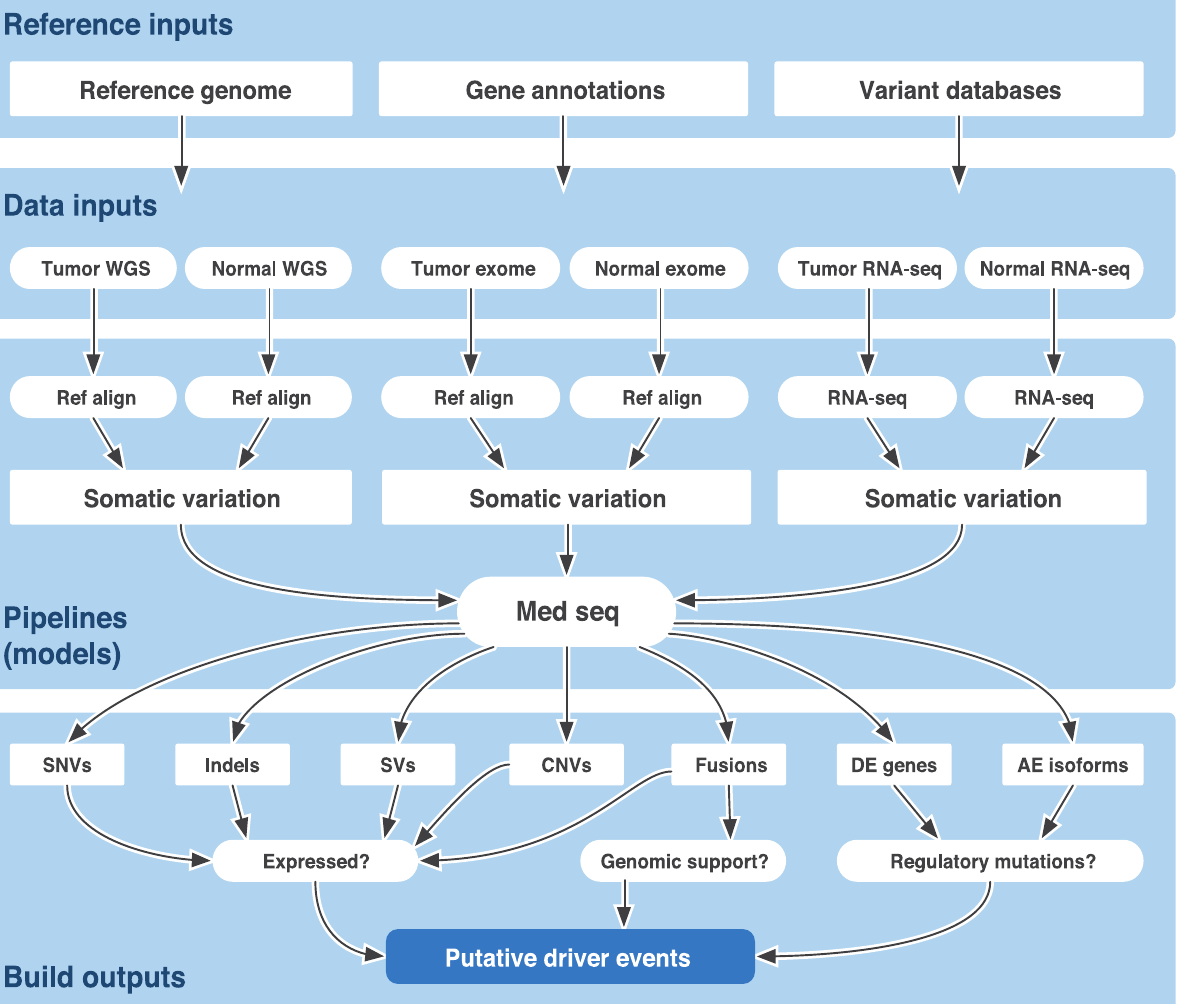
Fig 4. HCC1395 ( “ TST1 ” ) example input, models, and outputs. A test dataset for the HCC1395 cell line is provided with the GMS software to allow testing of software installation, and facilitate further development. It is also used to illustrate much of the current functionality of the GMS. HCC1395 tumor and the corresponding HCC1395BL ‘ normal ’ cell line DNA and RNA samples were sequenced by whole genome, exome, and RNA-seq methods producing six sets of instrument data for input to various GMS pipelines. Additional required inputs for the pipelines include a reference genome (e.g., GRCh37), gene annotations (e.g., Ensembl 67_37l), and variant databases (e.g., dbSNP37). Different versions (processing profiles) of the reference alignment were used to align WGS and exome DNA reads to the reference genome. A separate RNA-seq pipeline similarly aligns RNA reads. Alternate versions of the somatic variation pipeline are used to call various types of variants from exome and WGS data by comparing tumor and normal reference alignments. A differential expression pipeline identifies significantly altered transcript expression levels by comparing the tumor and normal RNA-seq alignments. Finally, the MedSeq pipeline summarizes all upstream pipelines into a single convenient result set. This includes a multitude of reports and visualizations for single nucleotide variants (SNVs), Indels (insertions and deletions), SVs (structural variants), CNVs (copy number variations), transcript fusions, differentially expressed genes, alternatively expressed isoforms, and much more. Data types are further integrated to, for example, identify which variants at the DNA level are expressed at the RNA level and which events affect known cancer driver genes or druggable targets.